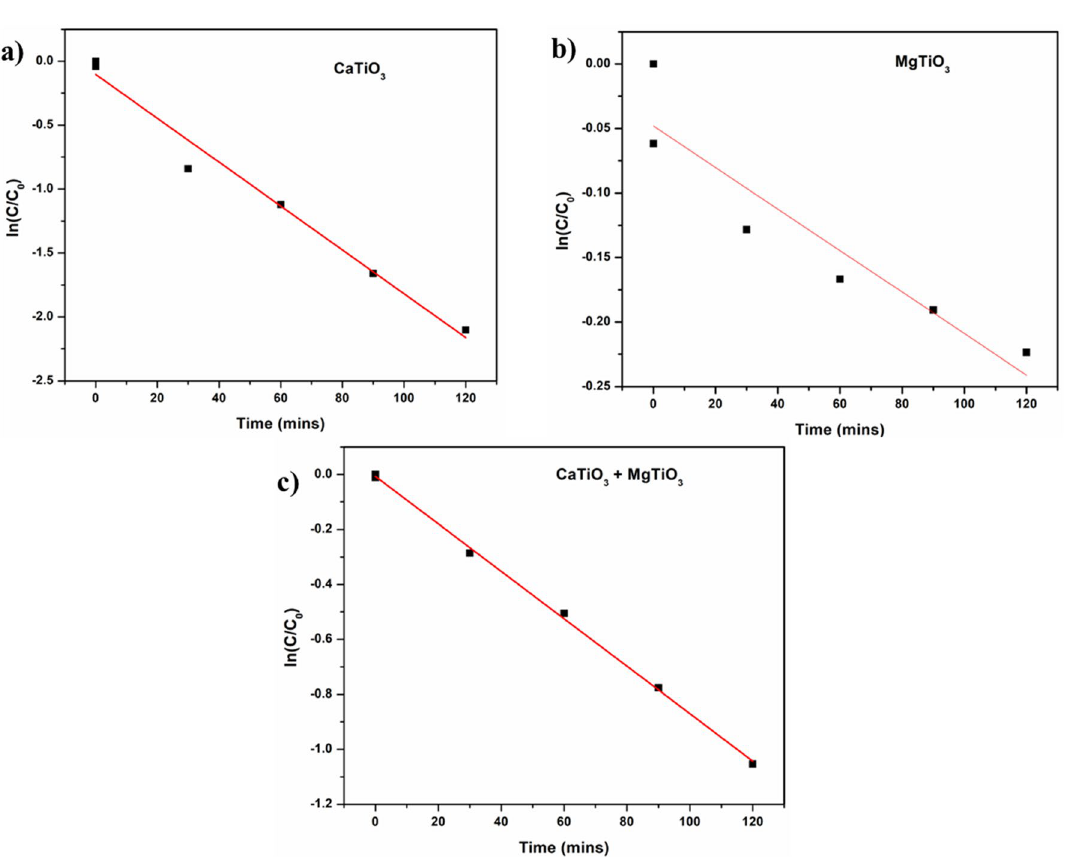
Figure 7. Kinetic plot of ( a ) CaTiO 3 , ( b ) MgTiO 3 and ( c ) CaTiO 3 + MgTiO 3